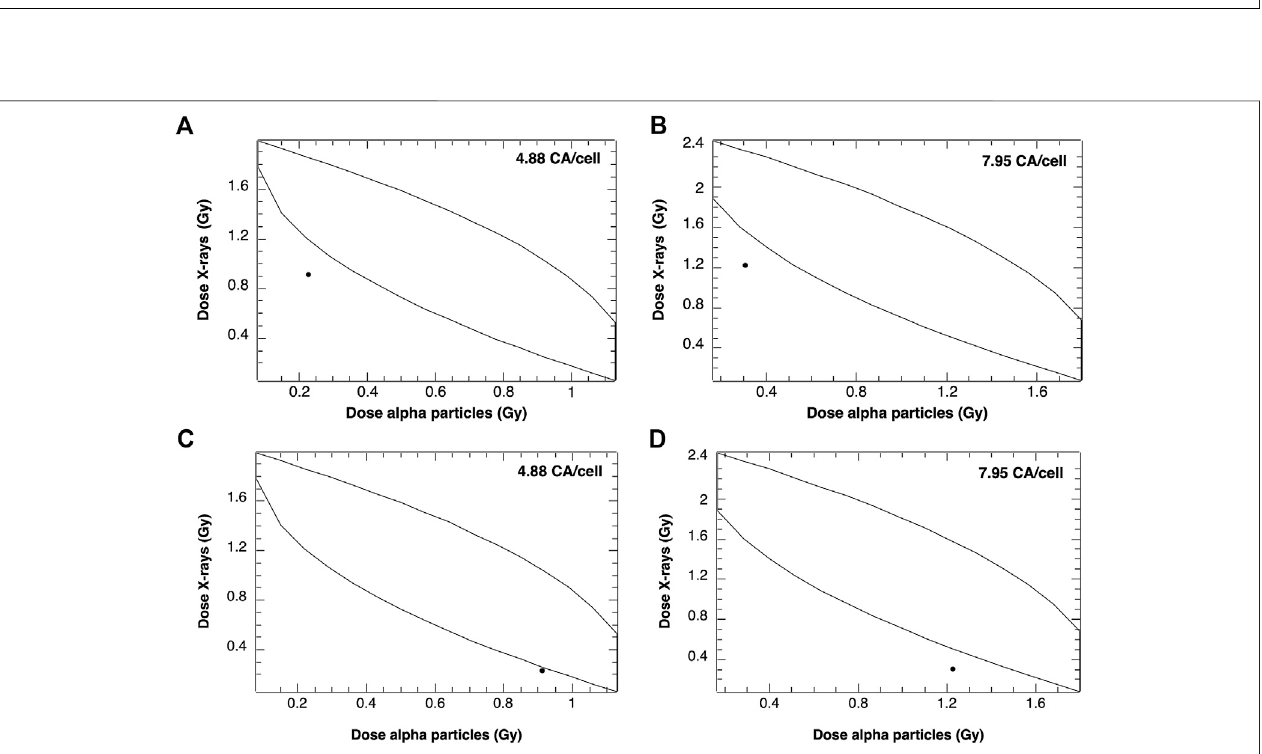
FIGURE8| Envelopesofadditivitycalculatedfor2selectedfrequenciesofCAformixedbeamscomposedof20%alphaparticlesand80%X-rays (A),(B) and80% alpha particles and 20% X-rays (C), (D) . The mixed beam doses for 4.88 CA/cell and 7.95 CA/cell were 0.94 and 1.53 Gy, respectively.